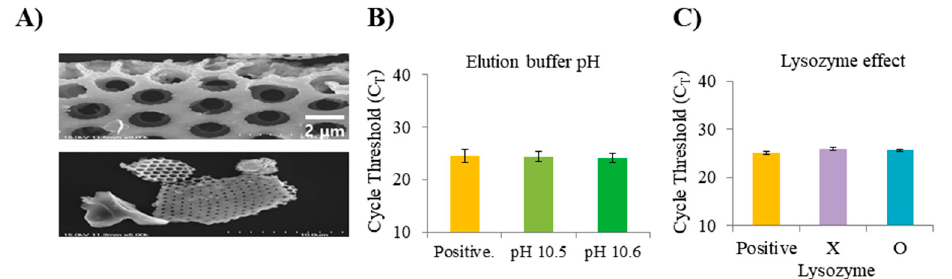
Figure 3. Evaluation to compare the efficiency of amine-functional diatomaceous earth (D-AMDPS). ( A ) SEM images of the surface of the D-APDMS. ( B ) C T values according to various elution buffer pH. ( C ) C T values according to the presence or absence of lysozyme. The C T values of 40 are samples that did not detect lysozyme. Error bars indicate standard deviation from the mean, based on at least three independent experiments.